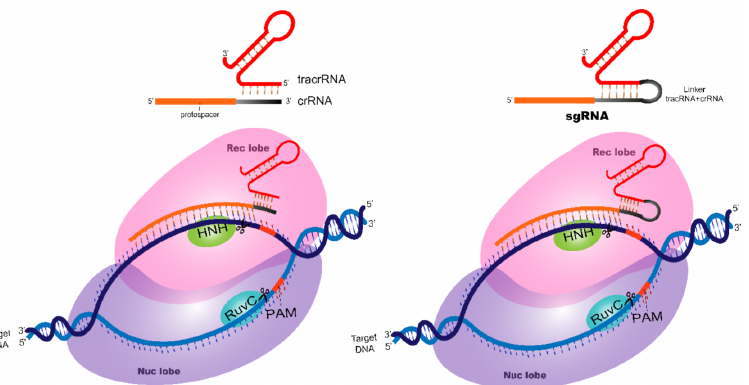
Figure 2. Structural differences among guide RNAs. Comparison of the crRNA associated with tracrRNA and the single-guide (sgRNA) structure. The junction of crRNA + tracrRNA with the linker loop resulted in the structure of single-guide RNA